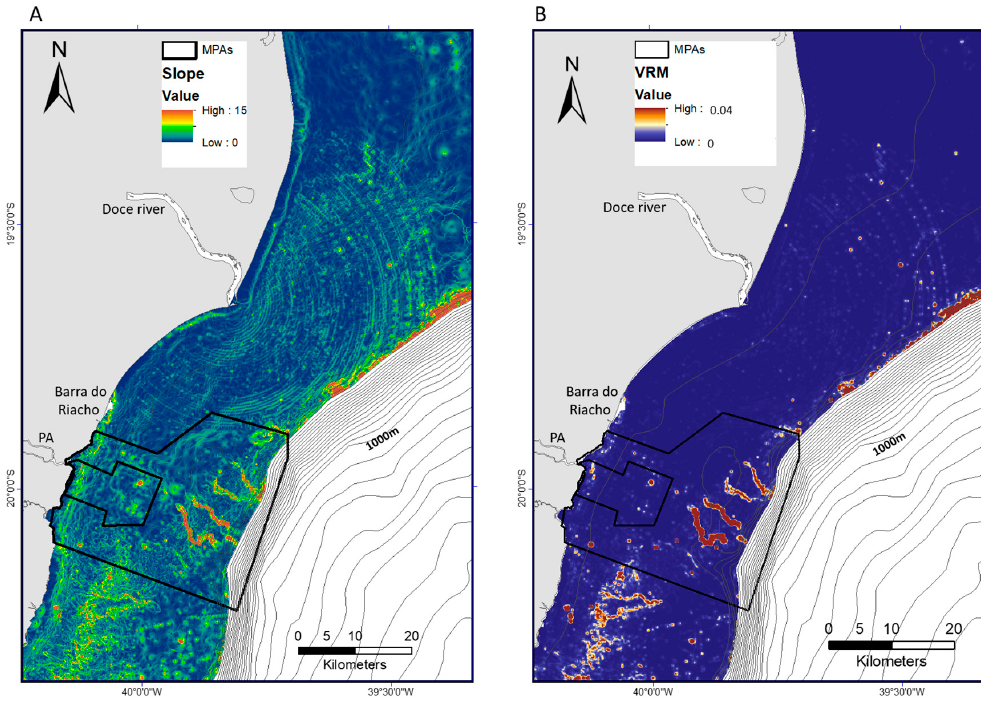
Figure 3. Terrain variables Slope (in degrees) ( A ) and Terrain Ruggedness; ( B ) calculated with the Vector Ruggedness Measure using ArcGIS tool Benthic Terrain Modeler (BTM). Datum is WGS 84. Depth contour intervals: 25 m from 0 to 100 m, 50 m from 100 to 1000 m, and 100 m from 1000 to 2000 m.